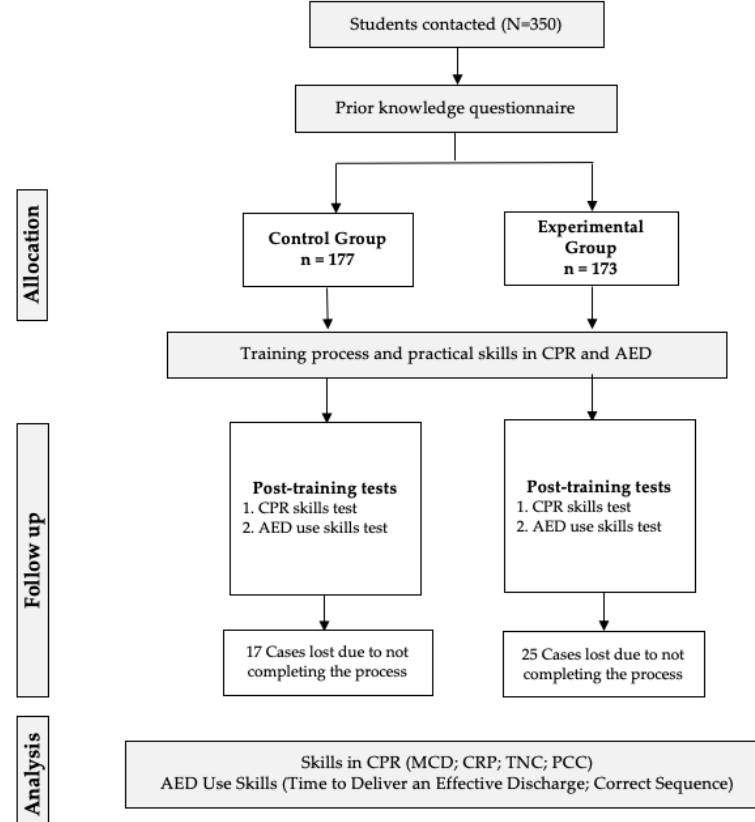
Figure 1. Research flowchart.